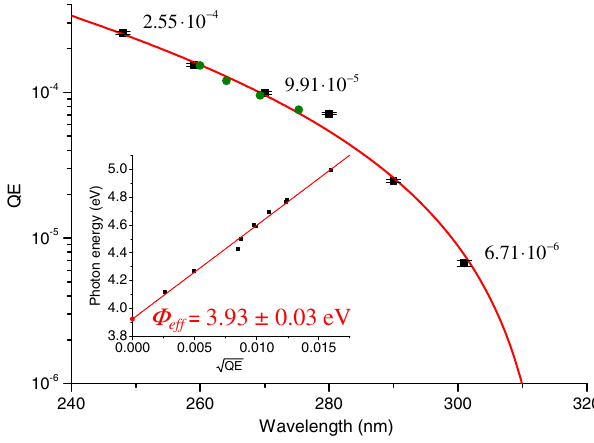
FIG. 3. (a) Core slice emittance as a function of the laser beam size for two laser wavelengths — 260.1 nm (dashed blue line) and 267.6 nm (red solid line) — for cathode Cu_3. The second order fit, taking into account the quadrupole component in the rf field, gives a linear component of 547 and 508 nm = mm, respectively. (b) The normalized intrinsic emittance increases with the laser beam size, contradicting Eq. (1) and is explained by the gun design.